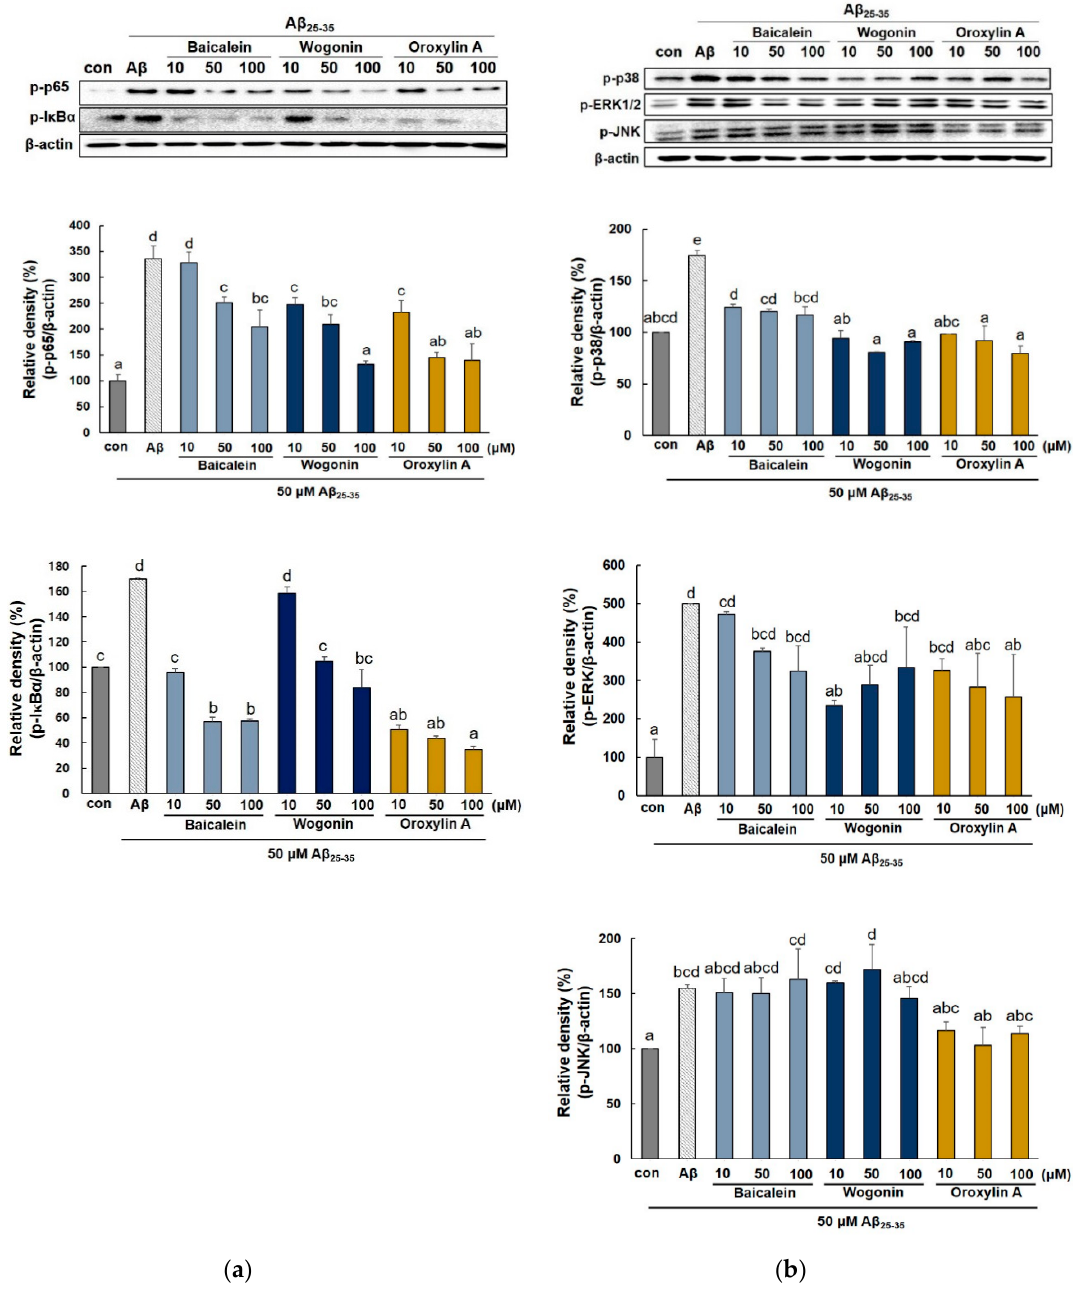
Figure 8. Effects of baicalein, wogonin, and oroxylin A on NF- κ B and MAPK expression in A β 25–35 -induced PC12 cells. Expression of p-p65, p-I κ B ( a ) and MAPKs ( b ). Cells were pretreated with the compounds for 1 h, and then incubated with A β 25–35 for 4 h. The cells were lysed and the protein levels were quantified using the BCA assay. Different alphabets indicate significant difference at p < 0.05.